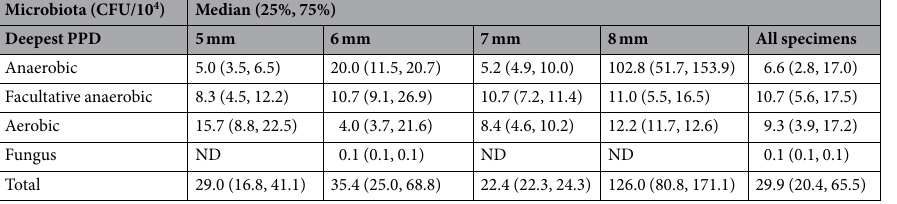
Table 2. Microbial counts of different microbial types among different depths of peri-implant pockets are presented in median, 25% and 75% quartiles (CFU/10 4 ). There are no statistically significant differences of anaerobic, facultative anaerobic and aerobic microbial counts among groups, nor between each pair of PPD groups ( p > 0.05). ND: not detected.